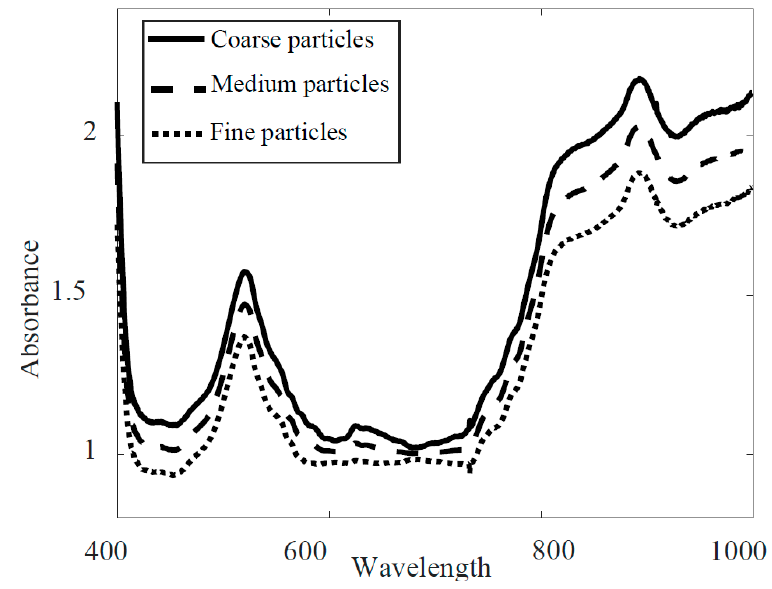
Figure 2. Average spectra of three different milk powder size fractions after pre-processing.